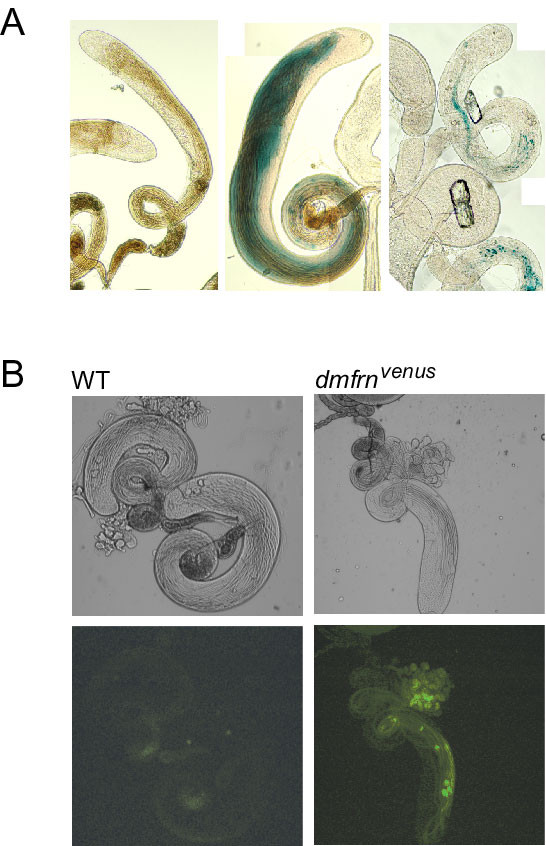
dmfrn expression in testes. (A) X-Gal stained testis of w1118 (left) flies, heterozygous (middle) and homozygous (right) dmfrnSH115 flies. (B) Light microscopy (upper row) and fluorescent microscopy (lower row) of testes from flies that do not express dmfrnvenus (WT) and flies that express dmfrnvenus (dmfrnvenus).